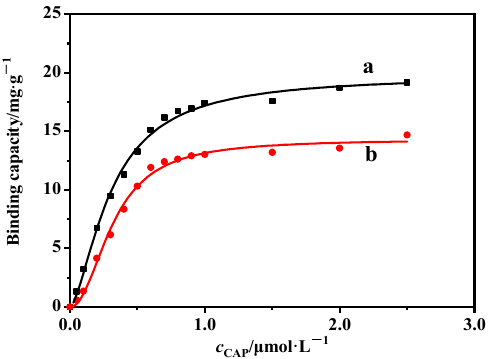
Figure 5. Isothermal adsorption of MIP@SiO 2 @QDs ( a ) and NIP@SiO 2 @QDs ( b ).